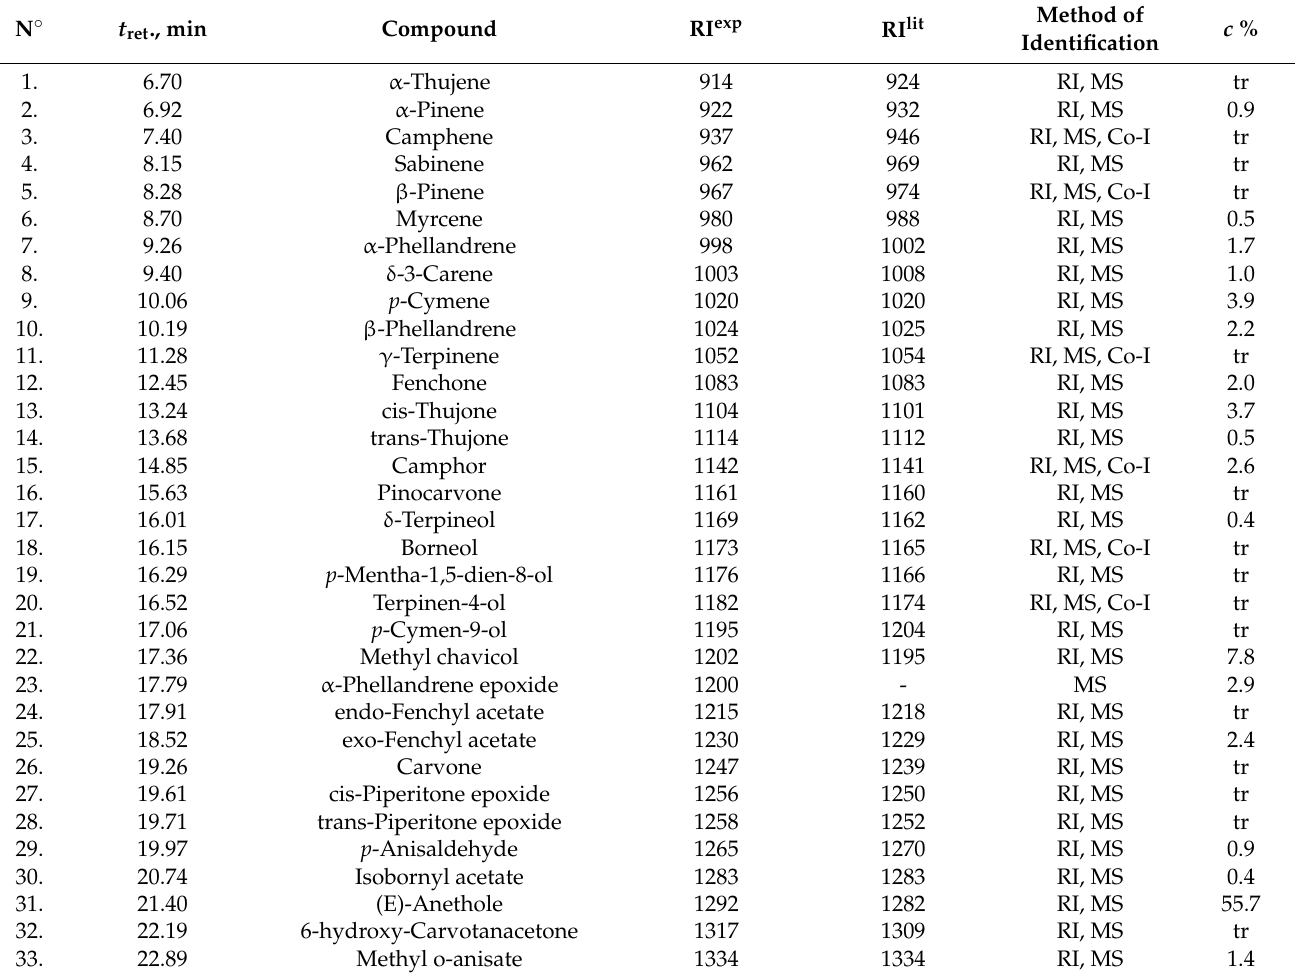
Table 2. Chemical composition of essential oil isolated from wild fennel stem.